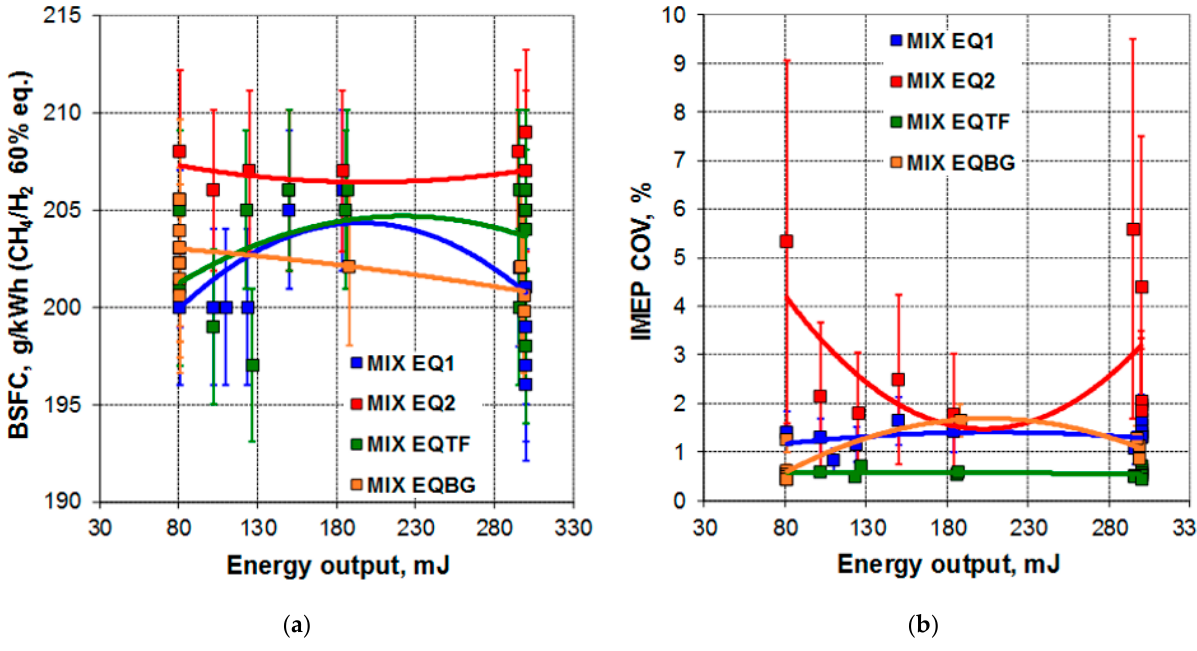
Figure 8. Different ignition condition data for operation with the equivalent mixtures at 1500 rpm and MAP 1250 mbar: ( a ) BSFC considering only the mass of CH 4 –H 2 ; ( b ) IMEP COV.